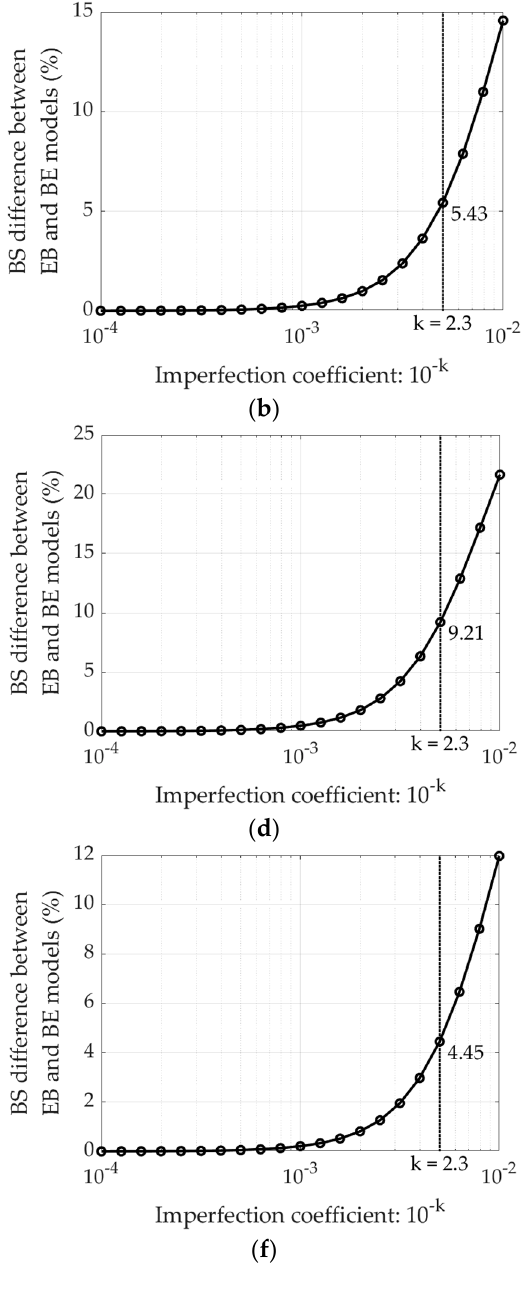
Figure 12. The difference in BS between the EB and BE configuration: ( a ) Board 1; ( b ) Board 2; ( c ) Board 3; ( d ) Board 4; ( e ) Board 5; ( f ) Board 6.